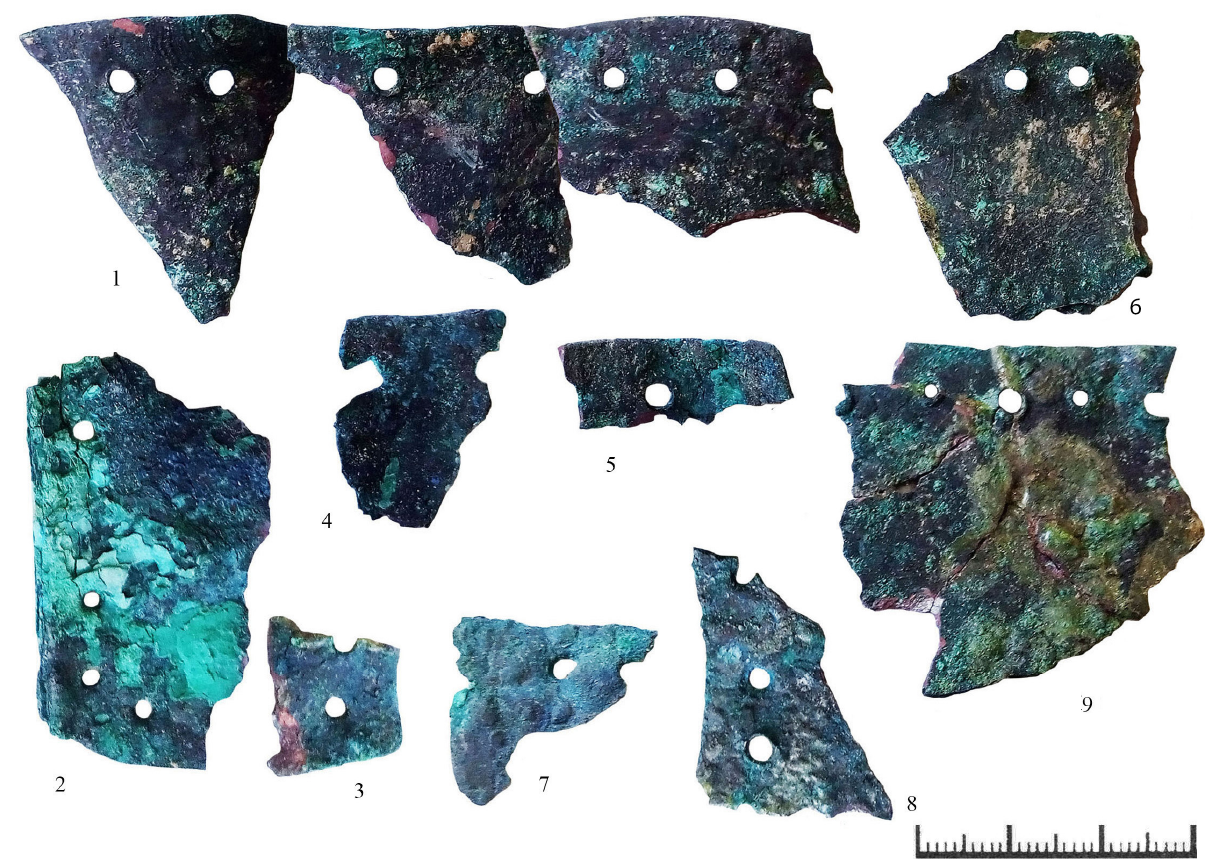
Figure 10. Vodoslavka Barrow 6 Burials 1–2. The right greave. (1)—bottom edge; (2), (3)—bottom corners, right and left; (4)–(9)—lateral edges (photograph М . Daragan). 3. Two fragments from the right and left bottom corners of the greaves (Figure